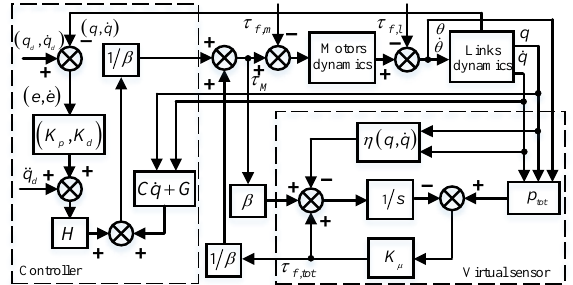
Figure 1. Diagram of a virtual sensor for estimating joint friction torque. The dotted box on the left represents the inverse dynamics controller algorithm, in which the input is the link desired trajectory and the output is the command torque. The dotted box on the right represents the proposed virtual sensor for estimating the total joint friction torque, in which the input is the actual position and velocity of the link and motor, and the output is the estimated joint total friction torque, which is finally compensated for by the controller to improve the controller performance, especially the that of the velocity.